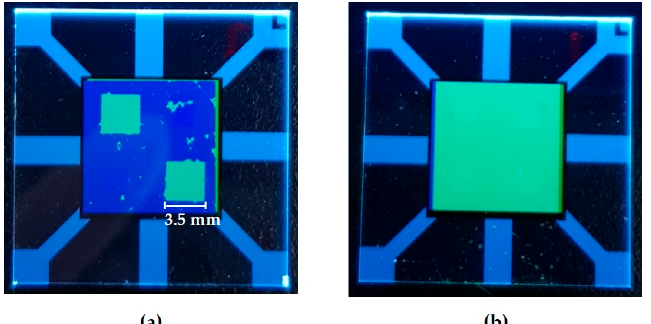
Figure 5. Photographic images of ( a ) the processed device after lift-off and ( b ) the reference device under an ultraviolet (UV) lamp. Table 2. Performance summary of a reference device and a processed device after lift-off.